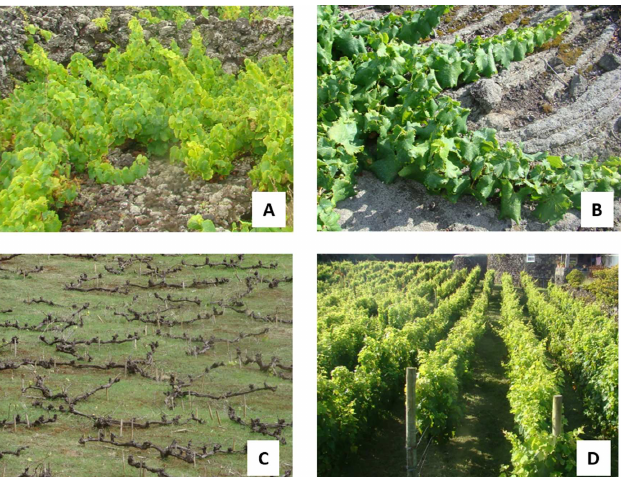
Fig 1. Combinations of soil type and grapevine training systemin the sampled vineyards. A: not- trellised grapevine (NT) in soil coveredwith stones (SS); B: NT in solidified lava flows (SL); C: NT in arablesoil (AS); D: trellised grapevines(TG) in